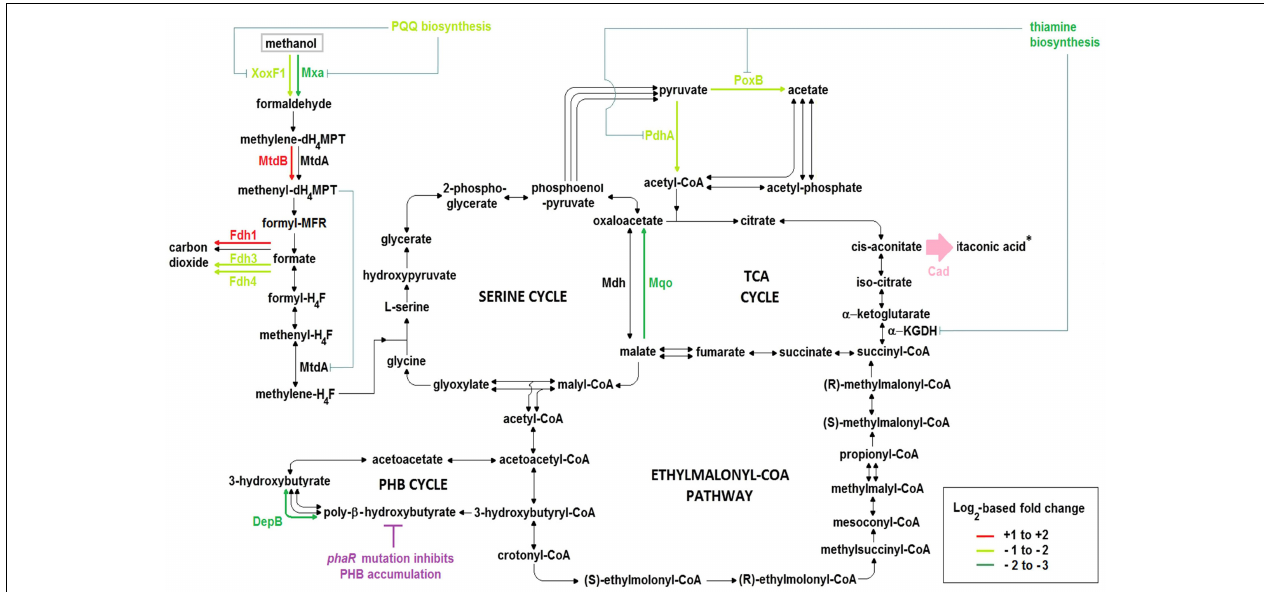
FIGURE 6 | Central carbon metabolic pathways, including key differences in the transcriptomes of (cid:49) phaR _CAD versus both WT_101 and WT_CAD. Experiments were performed in the HM medium with 240 mM methanol as the carbon source. Asterisk ( ∗ ) denotes ITA production by the heterologous Cad (pink color), while the phaR mutation causes deficiency in PHB accumulation (magenta color). The color of the arrows in the pathway indicates the level of differential gene expression according to the legend where the + and – signs denote up- and down-regulation, respectively, while black arrows represent genes in pathways that were not differentially expressed. Blue lines indicate possible inhibition or reduction of enzyme activities by a metabolite or as a result of diminished co-factor biosynthesis. PQQ, pyrroloquinoline quinone; XoxF1, lanthanide- and PQQ-dependent methanol dehydrogenase; Mxa, calcium- and PQQ-dependent methanol dehydrogenase; MtdA, methylene-dH 4 MPT/H 4 F dehydrogenase; MtdB, methylene-dH 4 MPT dehydrogenase; Fdh1, tungsten- and NAD-dependent formate dehydrogenase; Fdh3, cytochrome-linked formate dehydrogenase; Fdh4, molybdopterin-binding oxidoreductase-like formate dehydrogenase; DepB, PHB depolymerase;